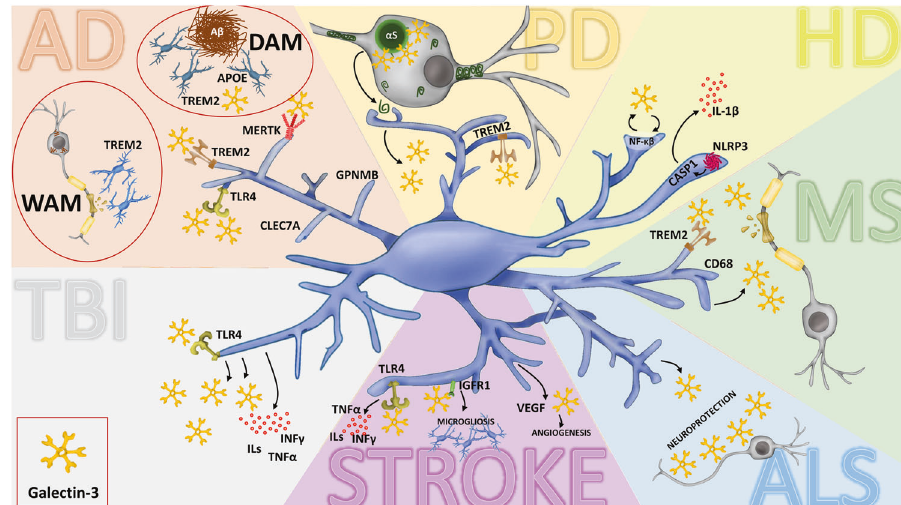
Fig. 4 Broad view of the role of Galectin-3 in microglia-associated neurodegenerative diseases. Galectin-3 (Gal-3) is one of the most highly expressed in Alzheimer ’ s Disease (AD) associated microglia (DAM) interacting with TREM2, TLR4 and MERTK. White matter-associated microglia (WAM) is also triggered by TREM2 activity but no role for Gal-3 has been yet uncovered. Gal-3 is found in the outer layer of the Lewy Bodies in neurons from Parkinson ’ s Disease (PD) patients, whereas internalisation of alpha-synuclein ( α S) by microglia leads to the release of Gal-3 to the extracellular matrix. In Huntington ’ s Disease (HD) Gal-3 is known to be released by microglia leading to in fl ammasome pathway activation and cytokine release. In Multiple Sclerosis (MS) Gal-3 is released in response to demyelinization and known to interact with TREM2. In Amyotrophic Lateral Sclerosis (ALS) microglia release Gal-3 which exerts a neuroprotective role, but no mechanism nor ligands have been identi fi ed. In Stroke, Gal-3 present a dual role binding to TLR4 and IGF1R to increase cytokine production and microgliosis, but also promoting VEGF release and angiogenesis. In Traumatic Brain Injury (TBI), Gal-3 is highly released after the trauma and binds to TLR4 predominantly to promote an intense in fl ammatory reaction associated to cytokine